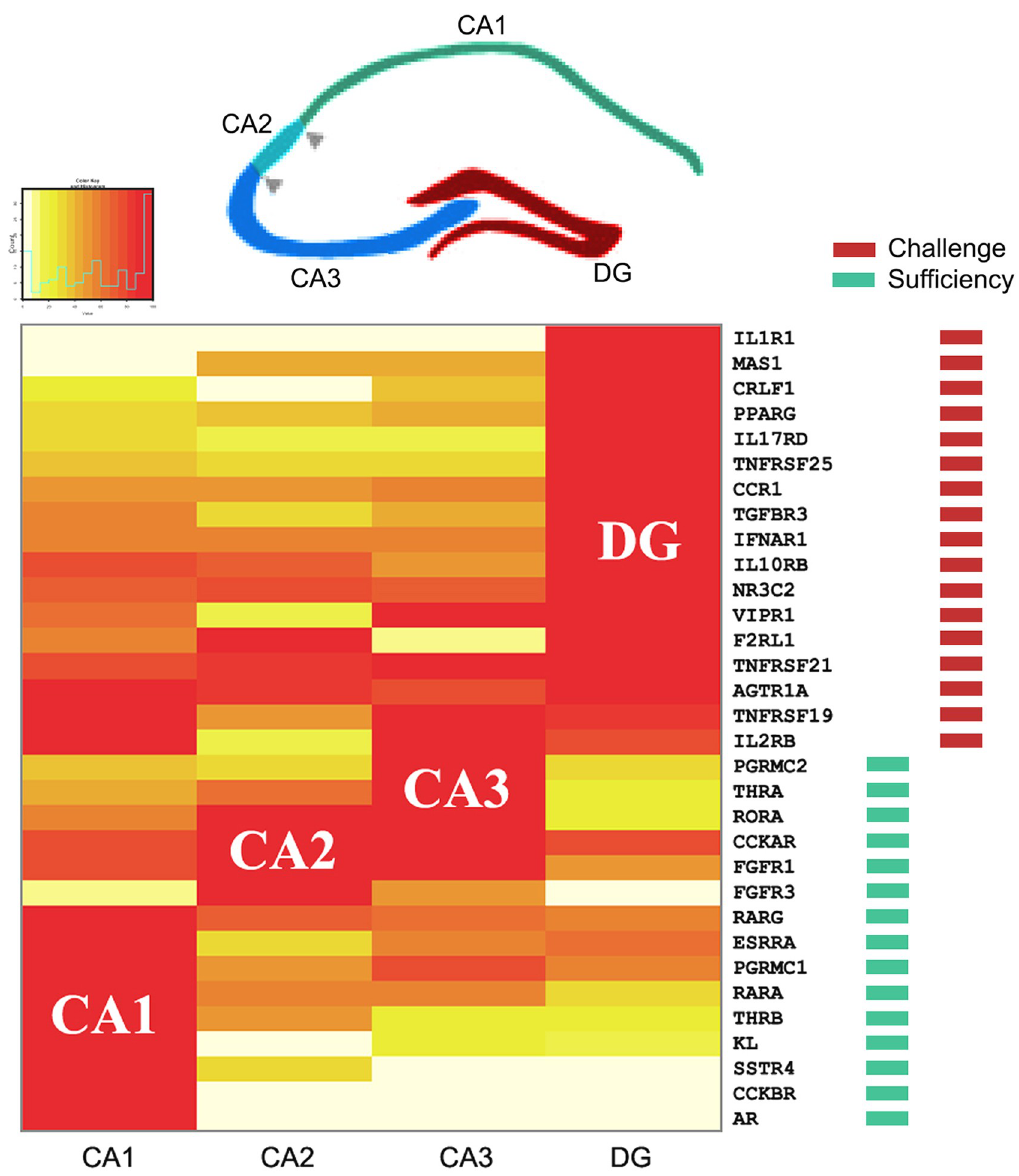
Fig 3. Expression of ’informative’ endocrine receptors in subregions of the mouse hippocampus (HPC). (Above) Principal neuroatomical subdivisions of the rodent HPC (adapted from the model of [15]). (Below) Informative (see main text) receptors sorted according to regional expression (heatmap, normalized data) with CA1 and DG at the two extremes (Methods) showing expression clustering of receptor types in different regions (e.g., ’sufficiency’–FGF receptors FGFR1, FGFR3, and KL in CA regions; and ’challenge’–interleukin and TNF receptors IL1R1, IL17RD, IL10RB, IL2RB, TNFRSRF 25, TNFRSF21, TNFRSF19 in